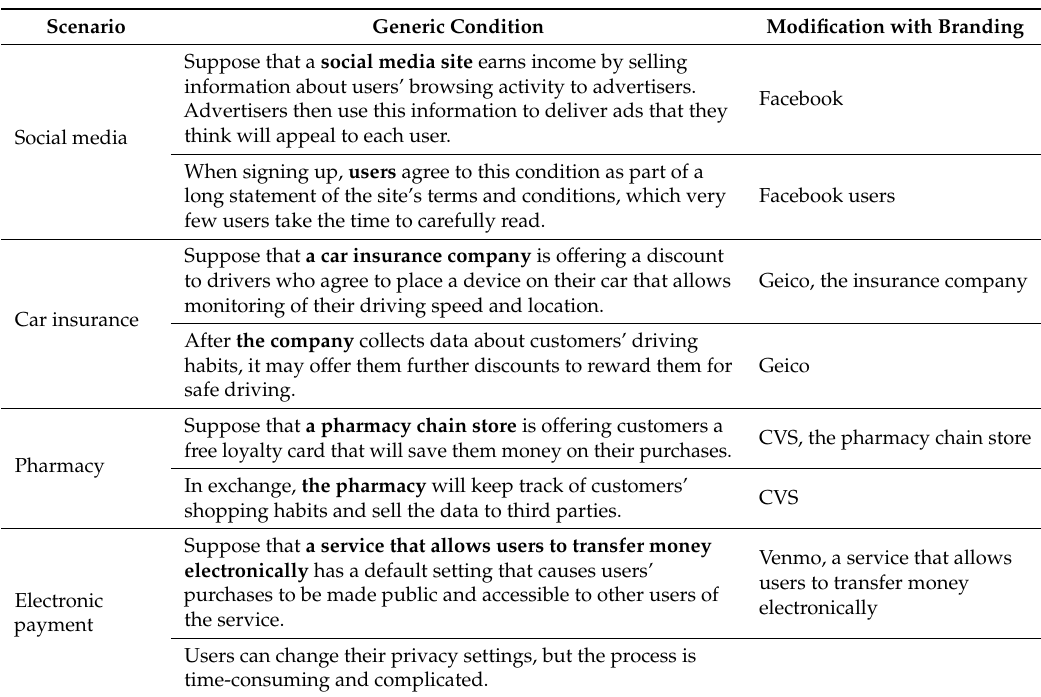
Table 1. Scenarios presented word-for-word.